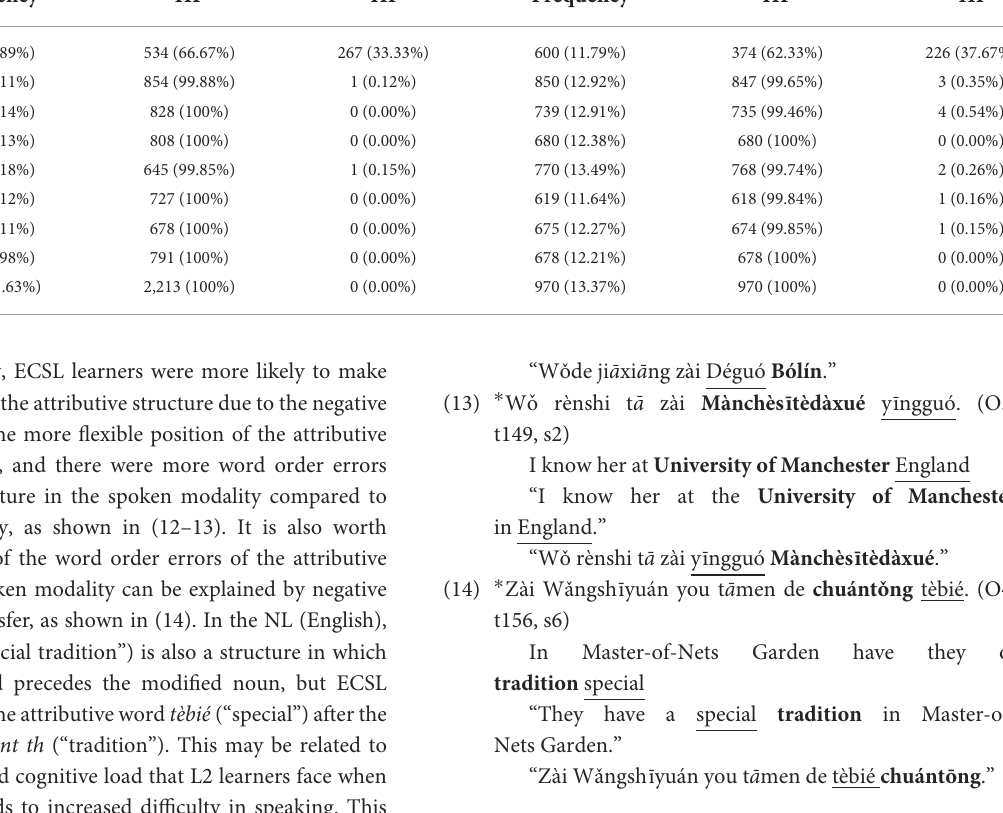
TABLE 5 Frequencies frequencies and dependency direction distributions of attributives at each level and in contrastive treebanks. Written Spoken Frequency HF